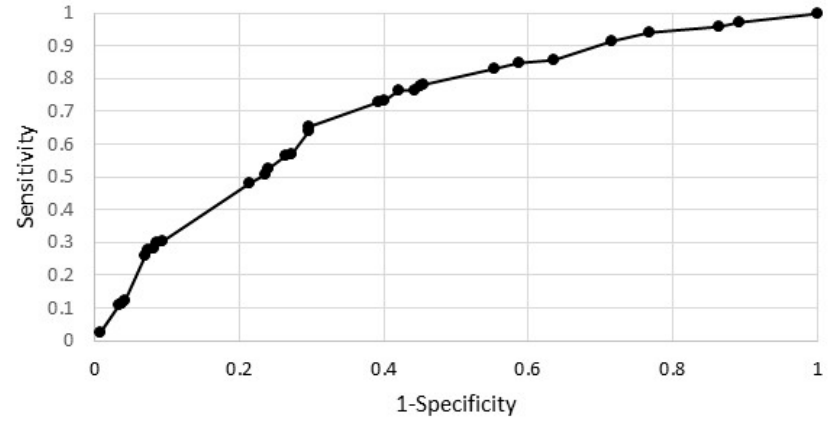
Figure 3. ROC Figure 3. ROC curve.